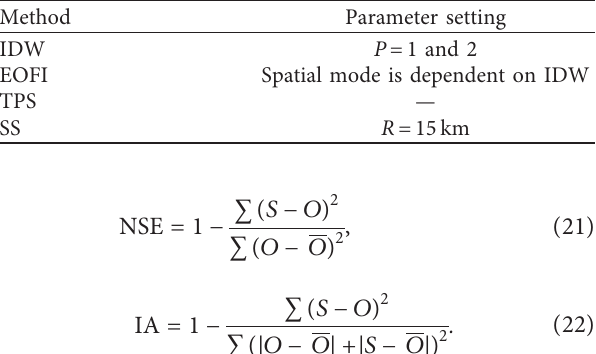
Table 1: Four interpolation methods parameter setting. Method Parameter